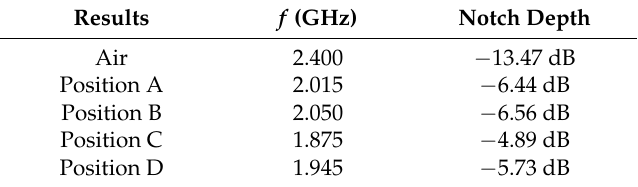
Figure 7. ( a ) Photograph of the sensors with the liquid sample in different positions; ( b ) Measured resonance characteristics of deionized water in different positions. Table 2. Transmission characteristics of the microwave sensor with deionized water in different positions.